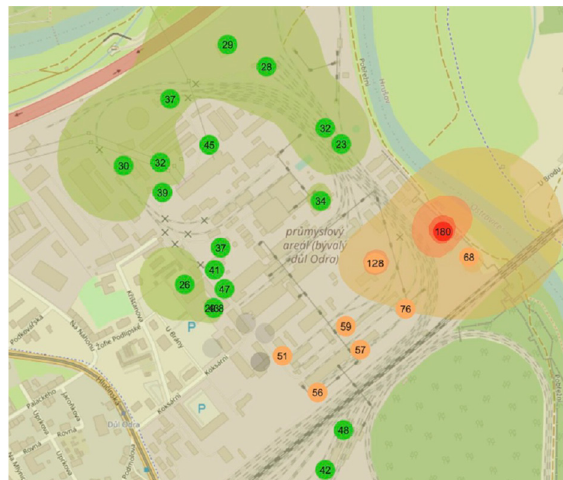
Figure 2. Layout of the field-measurement sensor network deployed in the industrial area. The individual units are marked with solid-colored dots. The currently displayed concentrations are indicated by a number inside the dot and the red, orange or green color of the dot depends on the value. The visualization system enables interpolation of data between individual units. These interpolations are displayed as a semi-transparent overlay.